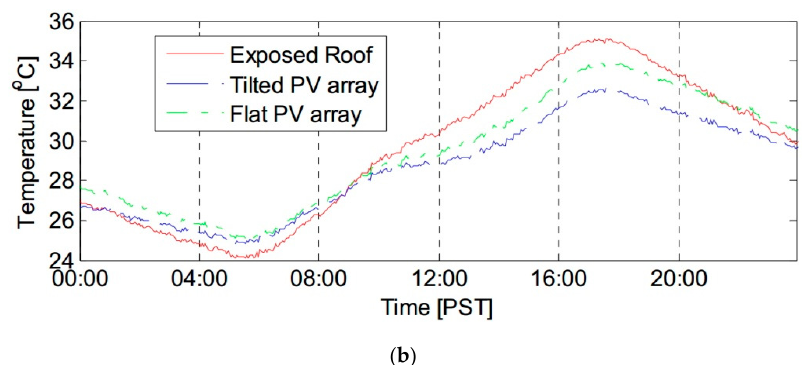
Figure 4. ( a ) Schematic diagram; ( b ) interior ceiling surface temperatures under exposed roof, tilted